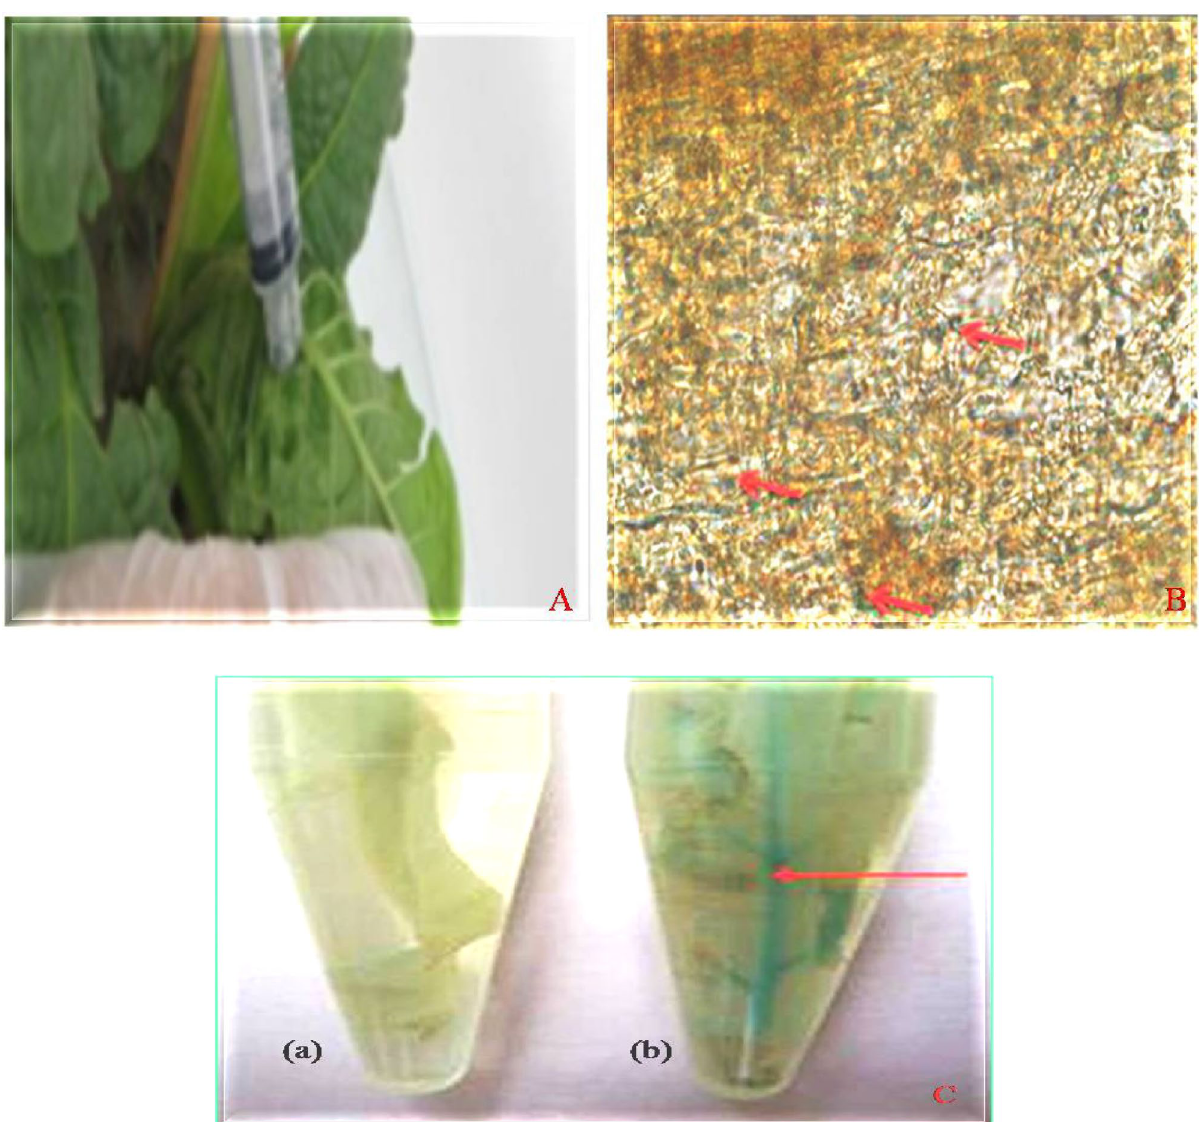
Figure 2. Through syringe method Agro -infiltrated Gus expression was efficiently observed in tobacco leaves. ( A ) Agro infiltrated tobacco leaves. ( B ) Bluish-green color under fluorescent microscope. ( C ) Visual GUS expression in Tobacco leaf (a): Non- Agro infiltrated tobacco leaves (negative control) (b): Agro infiltrated tobacco leaves predicting bluish-green Screening of sugarcane putative transgenic plants (CPF-246) with glyphosate resistance. For the optimization of glyphosate resistance four selection pressures were given to the transformed callus as well as regenerated transgenic and control plantlets (Fig. 4). After, 48 h of bombardment the transformed calli were transferred on kanamycine (50 mg/L) selection media. Following one week, survived calli were shifted to the regeneration media (RM-1 and RM-2) containing Kanamycine 50 mg/L and Glyphosate 40 mM. After 2-weeks resistant transgenic plants were further multiplied on shoot multiplication media (SMM-2) contained glypho- sate concentration (50 mM). GUS transient expression for the screening of transgenic sugarcane plants. Plasmid con- structs p CEMB-SC12 and p CEMB-SGTG was transformed in the sugarcane calli through Biolistic delivery sys- tem. These calli containing three transgenes and were regenerated on double selection pressure Kanamycine (50 mg/L) and Glyphosate (45 mM). Young regenerating plants from the screened resistant calli were further selected through the GUS assay. The transgenic expression of GUS assay of reporter gene was done for early detection of transgenic events. After visual observation, GUS expression in leaves and stems is further confirmed by a fluorescent microscope, cells were showing uniform expression through its evenly distributed bluish green color in cross sections, depicting the success of whole transformation process (Fig. 5).